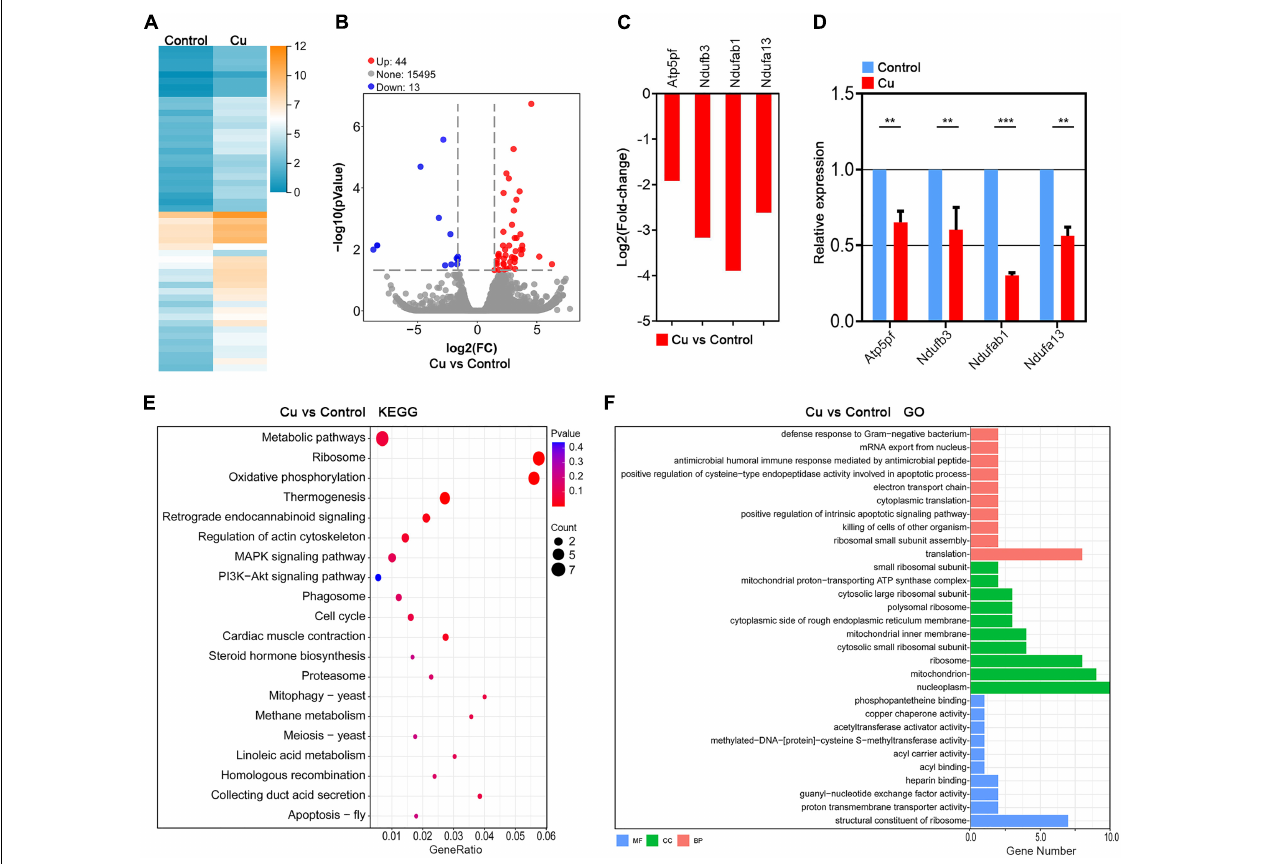
FIGURE 4 | Transcriptome analysis identifies target effectors of Cu in porcine oocytes. (A) Heatmap illustration showing the gene expression of the control and Cu-exposed groups. (B) Volcano plot showing the differentially expressed genes (DEGs; upregulated, red; downregulated, blue) in the control compared with Cu-exposed oocytes. (C) RNA-seq results of the selected genes in the Cu-exposed oocytes compared with the control ones (red). (D) Validation of the RNA-seq data by quantitative RT-PCR in the control oocytes (blue) and the Cu-exposed oocytes (red). Data were presented as the mean percentage of at least three independent experiments (mean ± SEM). ** P < 0.01, *** P < 0.001. (E) KEGG enrichment analysis of DEGs in the Cu-exposed oocytes compared with the control ones. (F) GO enrichment analysis of DEGs in the Cu-exposed oocytes compared with the control ones. Orange represents biological process; blue represents molecular function; and green represents cellular